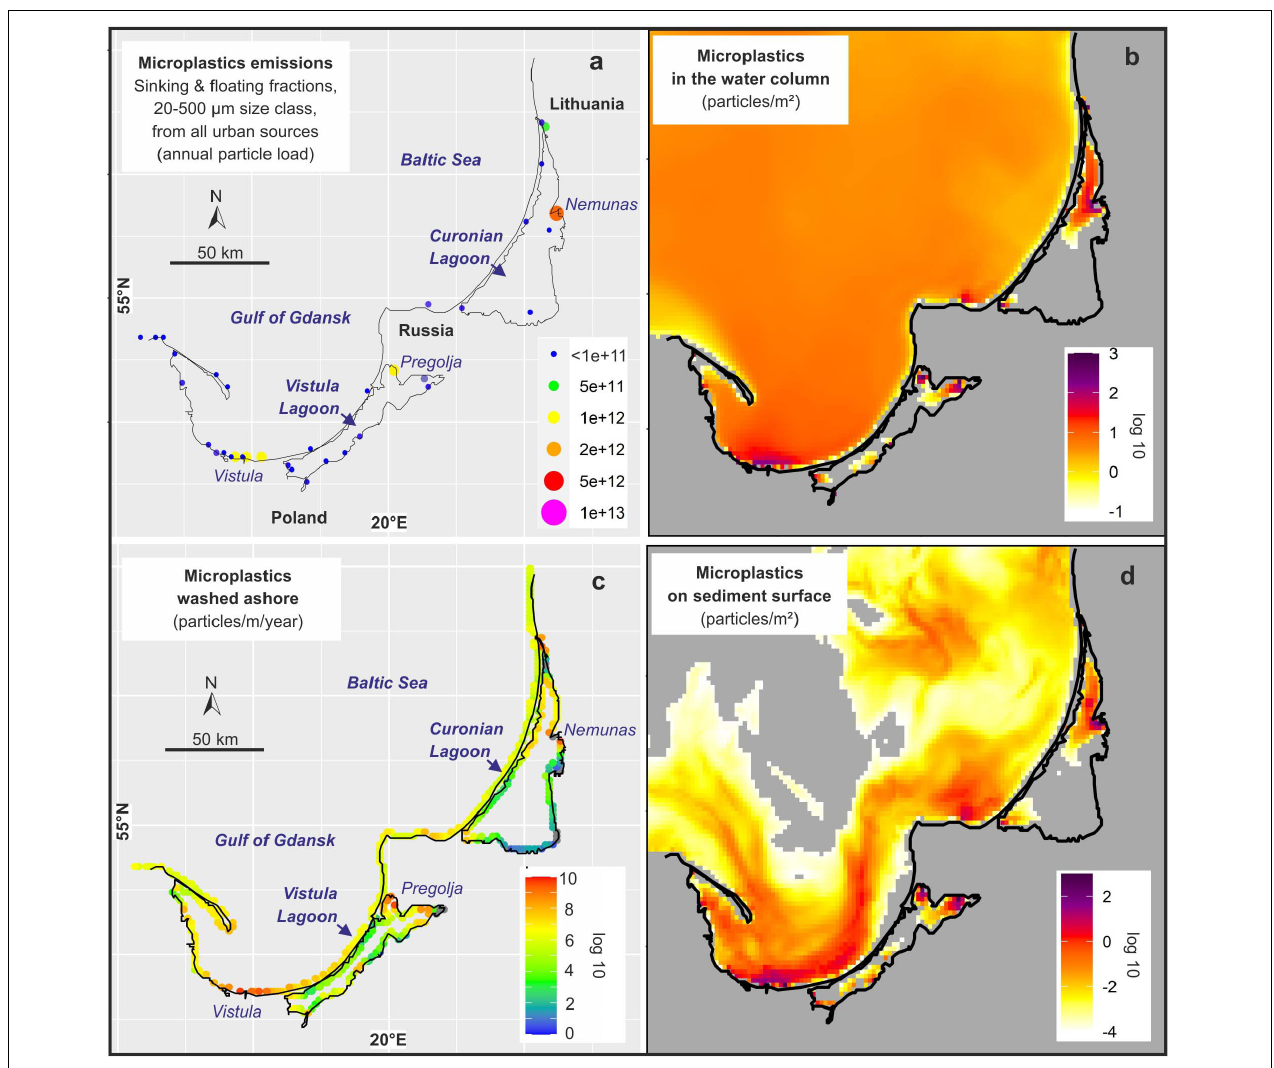
FIGURE 3 | Wider Gulf of Gdansk area: (a) emissions of microplastic particles from all three urban pathways to the Baltic Sea assuming no retention in rivers; (b) average annual spatial concentration of microplastic particles (20–500 µ m size fraction) in the water column of the Baltic Sea; (c) concentrations at the sediment surface and (d) accumulation of micro-plastics particles (20–500 µ m size fraction) at the shore and based on simulations with a 3D hydrodynamic model. Grey areas in the sea indicate concentration below the colour